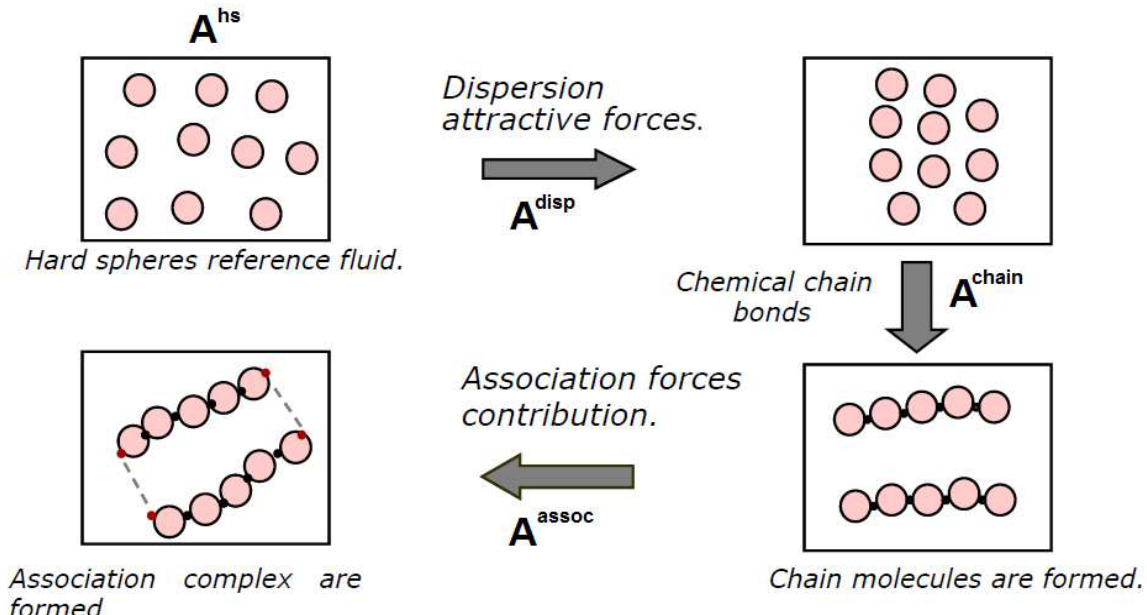
Figure 5. Schematic of different contribution to Helmholtz free energy in SAFT theory. Reproduced with permission from [136]. Copyright 2015, Elsevier.